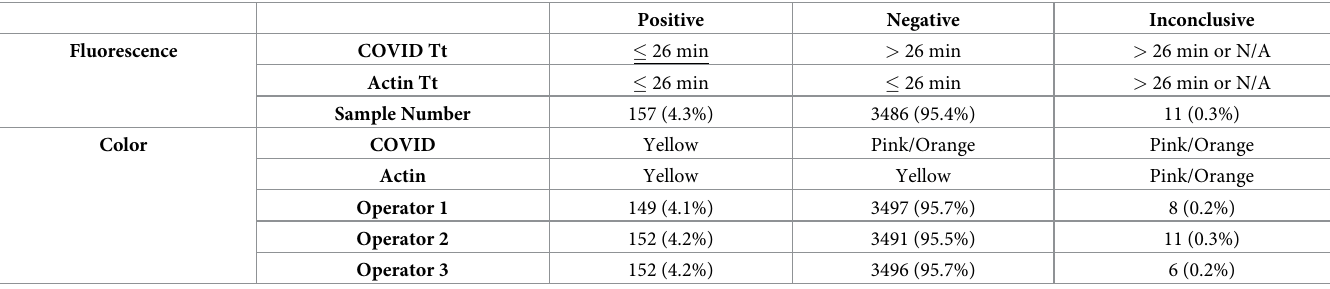
Table 2. Comparison of the two assay readouts: Fluorescence versus color